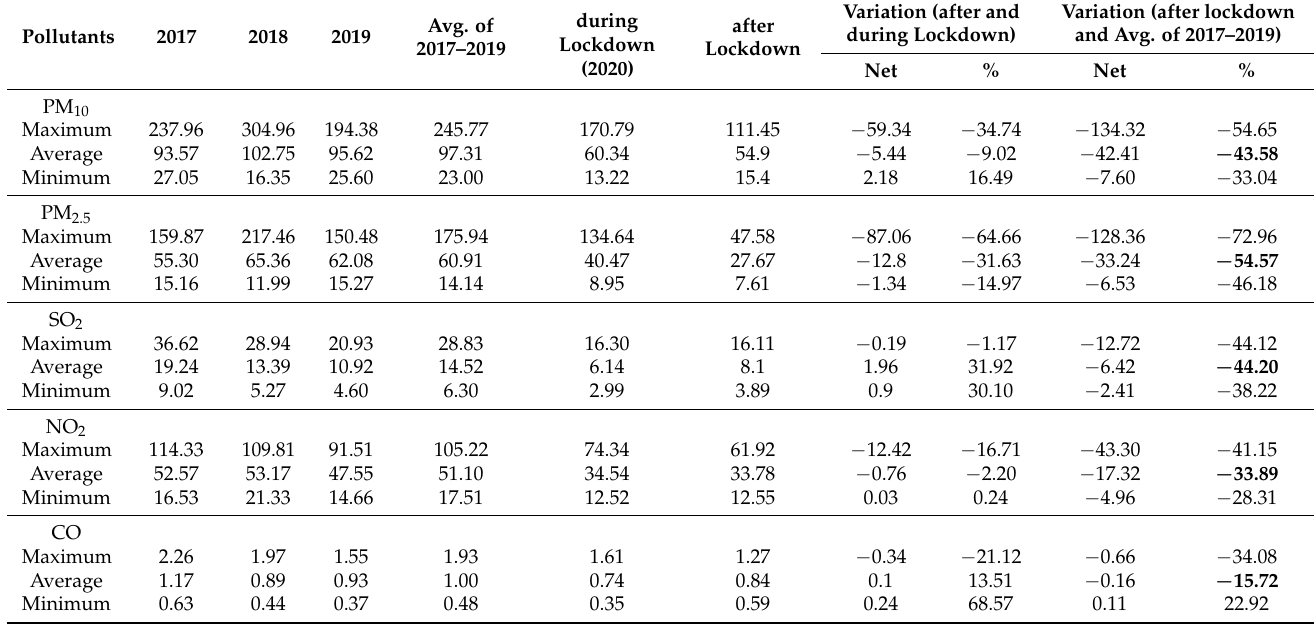
Table 3. 24 h average concentration and variation of pollutants for the periods of 2017–2020 to after lockdown in Nanjing. (Bold values show average maximum